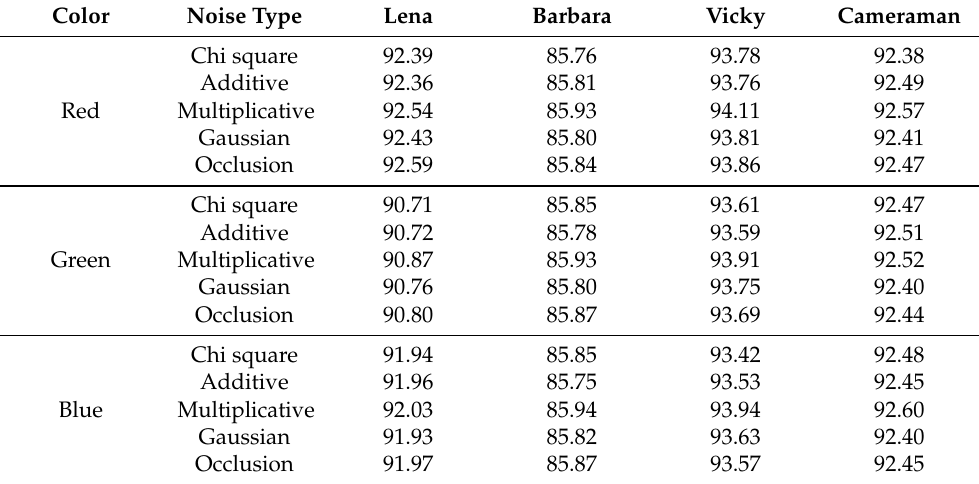
Table 15. SP after a 5 × 5 median filter was applied to encrypted images with 40% damage from different noise